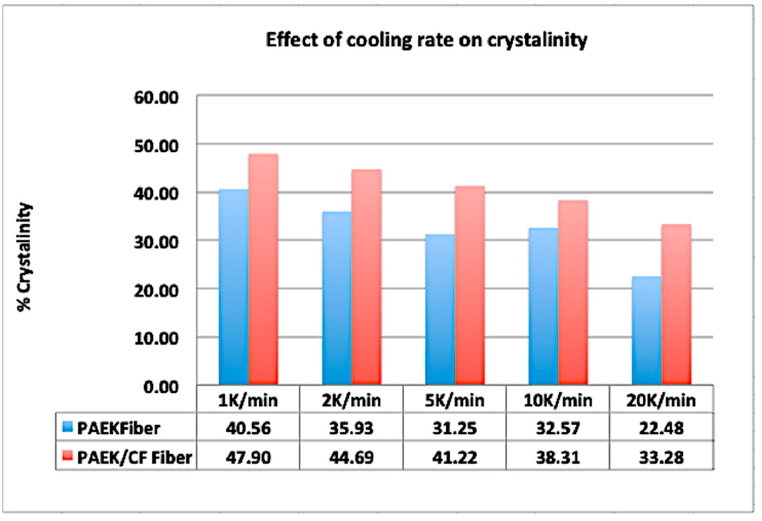
Figure 2. The percent crystallinity for di ff erent cooling rates is calculated by measuring the area under the curve as shown in Figure 1